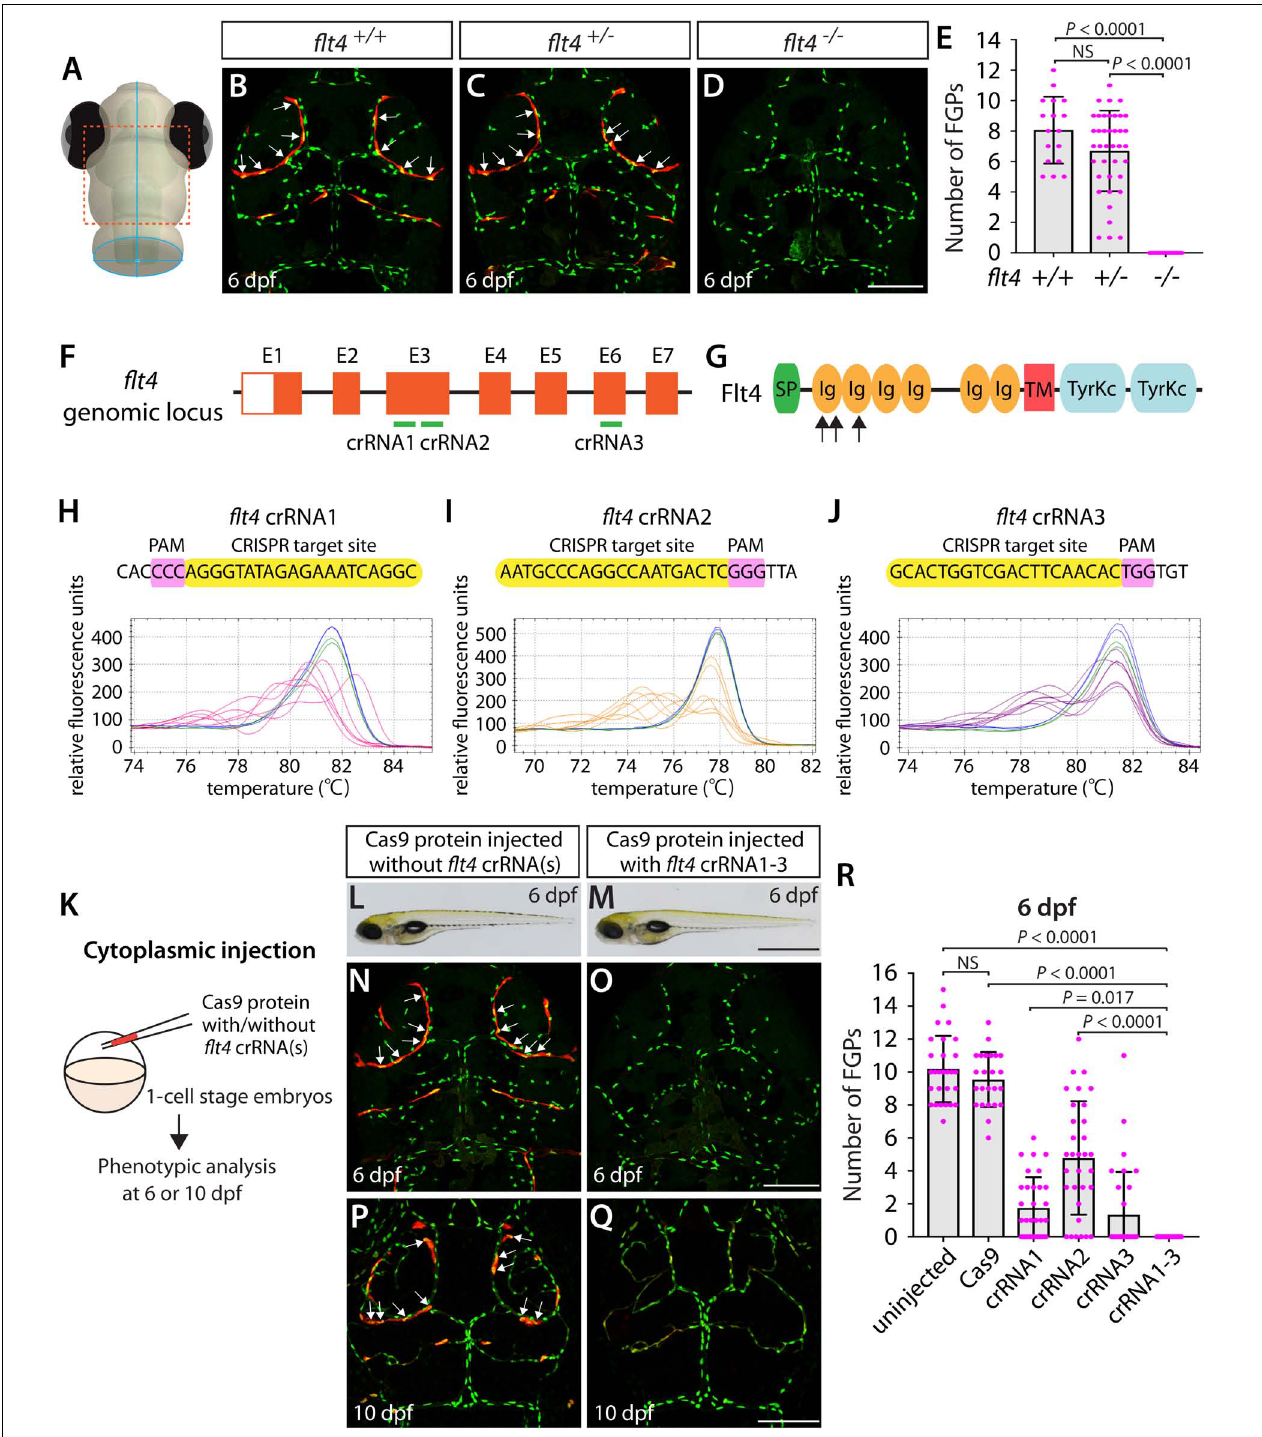
FIGURE 2 | Larvae injected with three unique flt4 dgRNPs phenocopied the complete loss of brain meningeal perivascular FGPs observed in flt4 − / − fish. (A) Schematic representation of the dorsal view of the zebrafish larval head. The boxed area indicates the approximate region where the confocal images of panels (B–D) were captured. (B–D) Dorsal head views of 6 dpf flt4 + / + , flt4 + / − , and flt4 − / − larvae carrying Tg(fli1:nEGFP) and Tg(lyve1:DsRed) transgenes. While flt4 + / + and flt4 + / − larvae formed Tg(fli1: nEGFP );Tg(lyve1: DsRed ) -double positive FGPs in the dorsal meningeal surfaces over the optic tectum (arrows, B,C ), flt4 − / − larvae completely lacked FGPs (D) . (E) Quantification of FGPs over the optic tectum for each genotype at 6 dpf ( n = 17 for flt4 + / + , n = 39 for flt4 + / − , and n = 21 for flt4 − / − fish). (F) Three synthetic crRNAs were designed to target sequences within exon 3 (E3) and E6 on the flt4 genomic locus. (G) Predicted domain structure of zebrafish